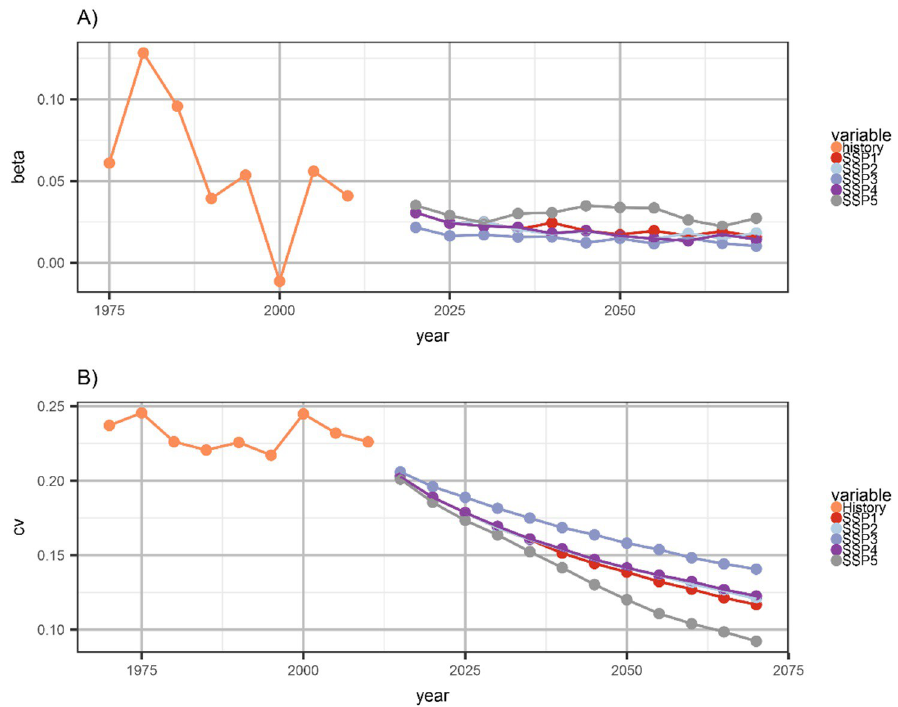
Fig 5. Convergence measures. (A) Beta measures of convergence, defined as the rate of personal income convergence derived from a regression of income growth rate on the logarithm of income in the base year (five year time step), and (B) sigma measures of convergence, measured as the coefficient of variation of per capita personal income across counties, for the historical period (1975–2010) and SSP projections (2015–2070).